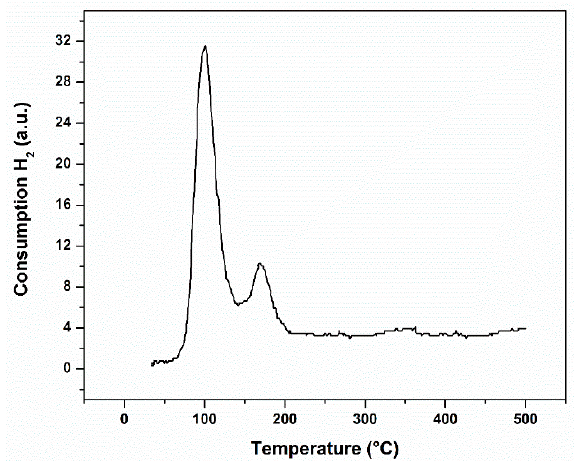
Figure 1. H 2 -temperature programmed reduction (H 2 -TPR) profile of the fresh catalyst.